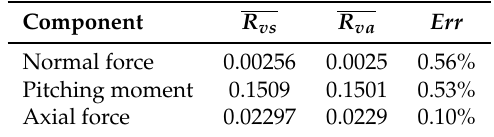
Table 1. Validation error of three-component (channel) data.